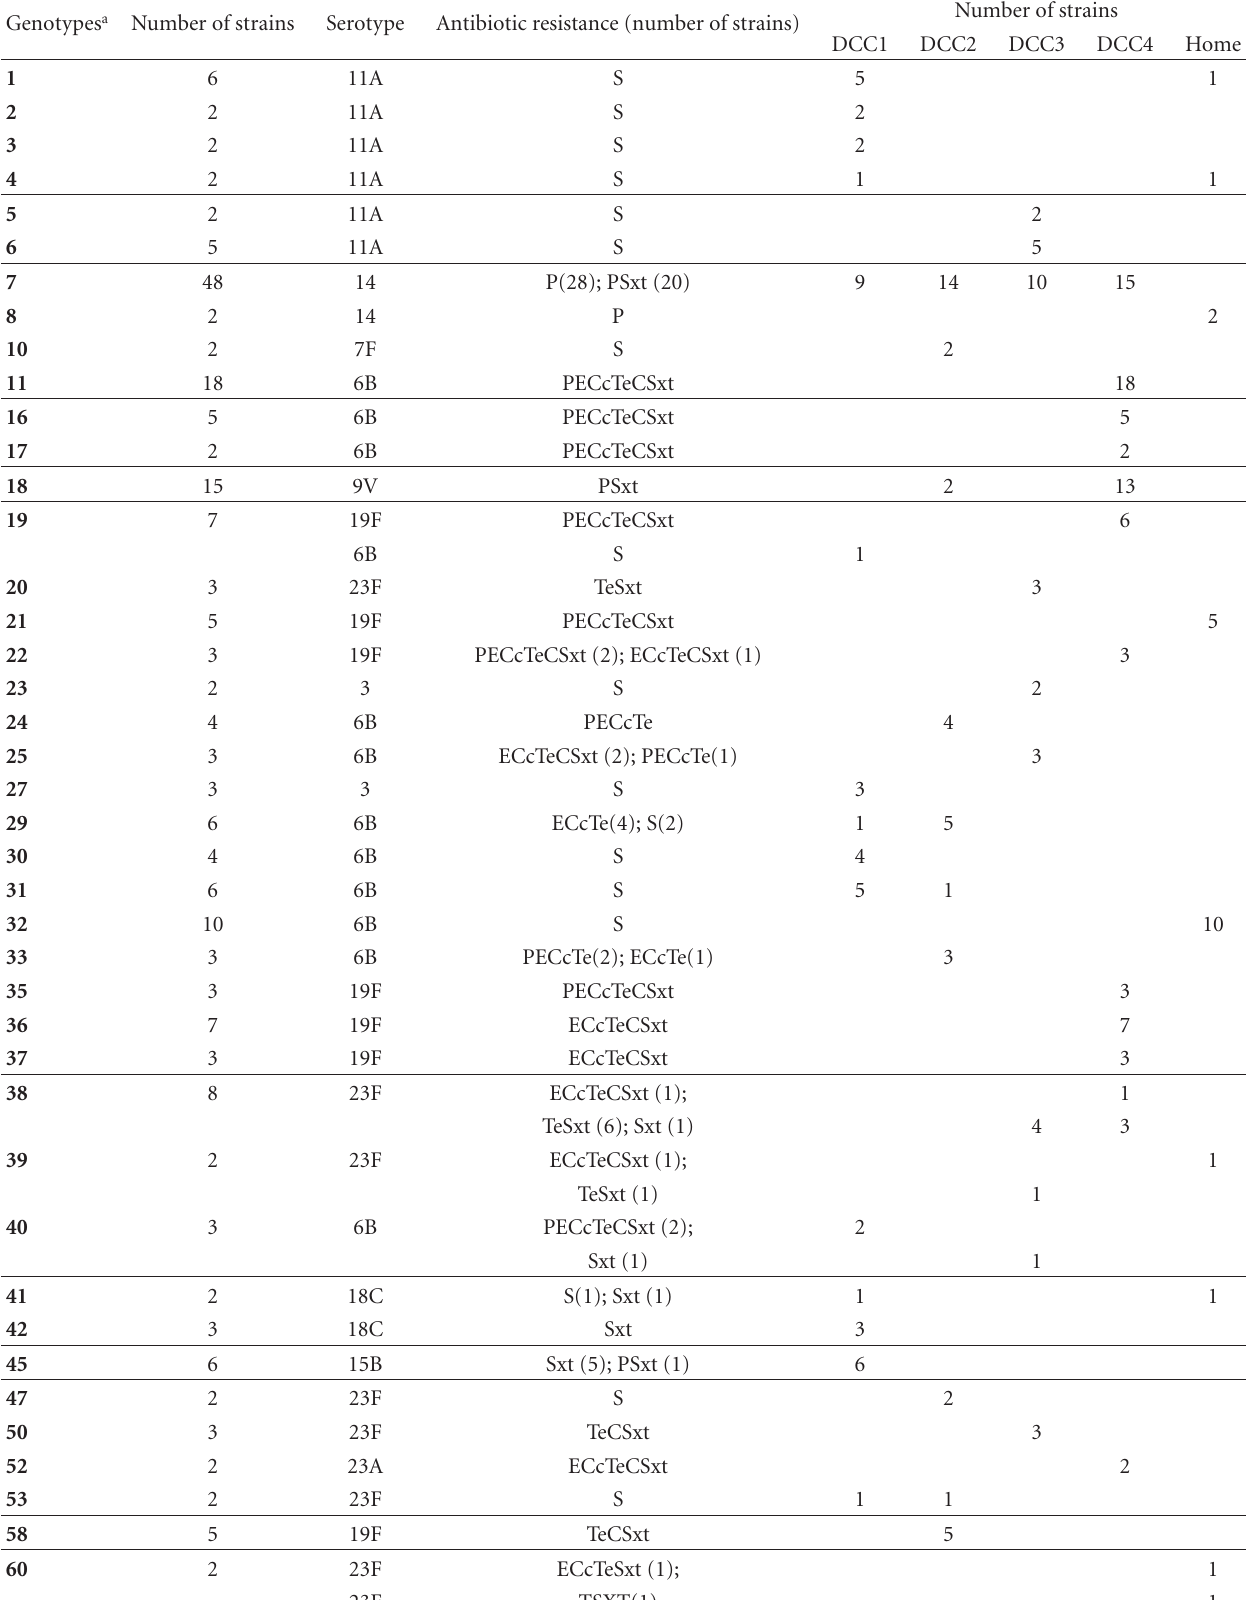
Table 4: BOX-PCR genotypes of S. pneumoniae isolates in healthy preschool children in DCCs and home group. Genotypes a Number of